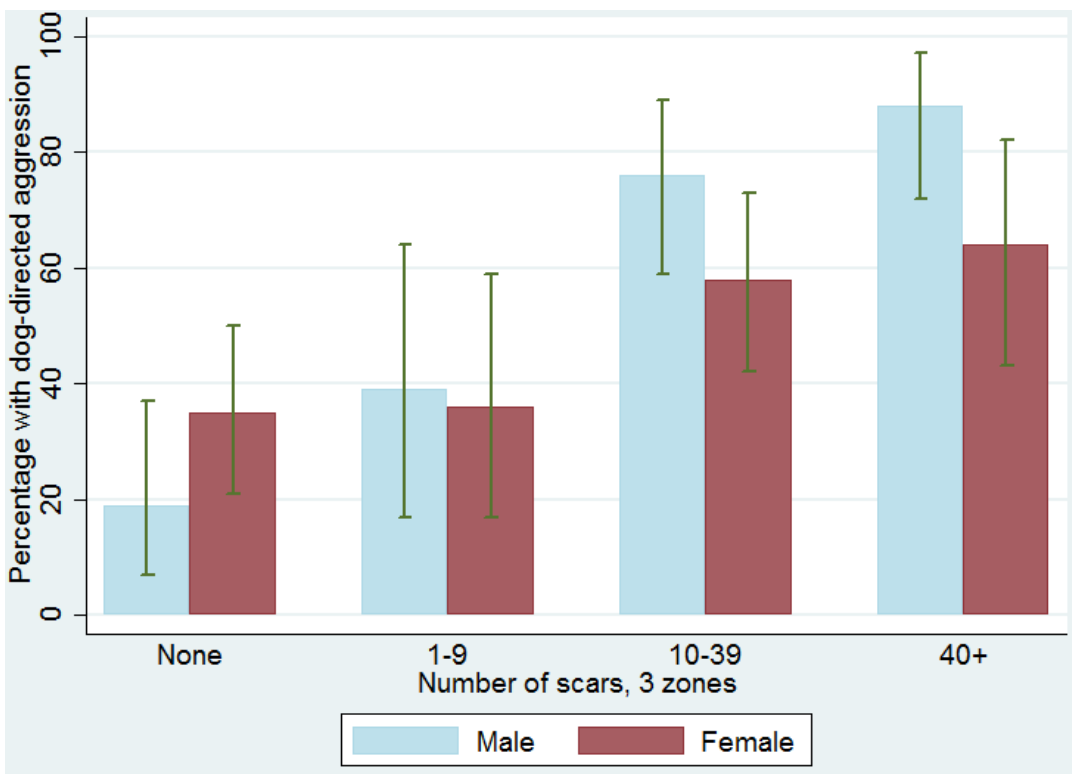
Figure 2. Percentage of dogs displaying dog aggression, by scar count and sex, with 95% confidence intervals.